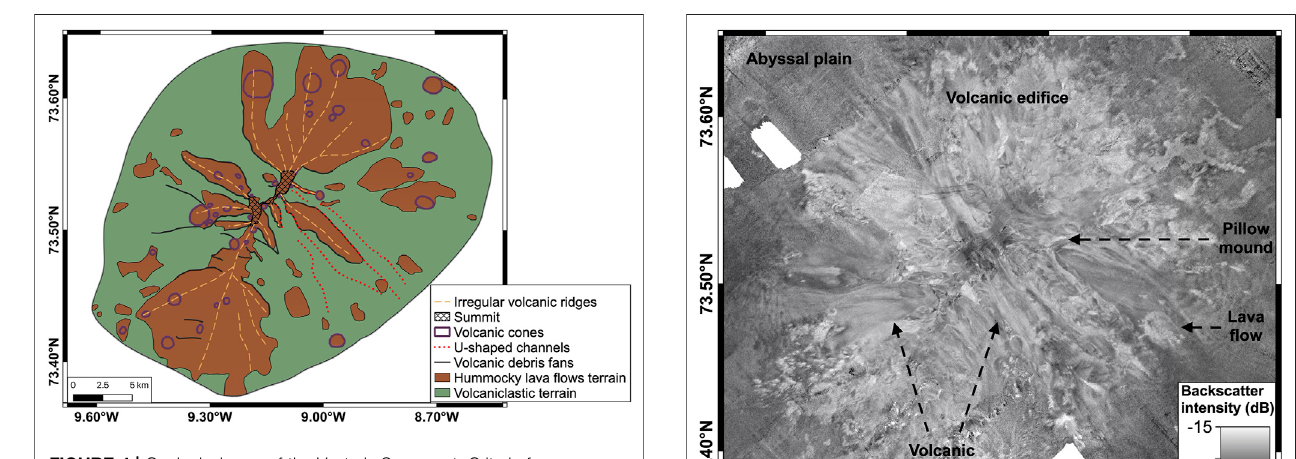
Frontiers in Earth Science |